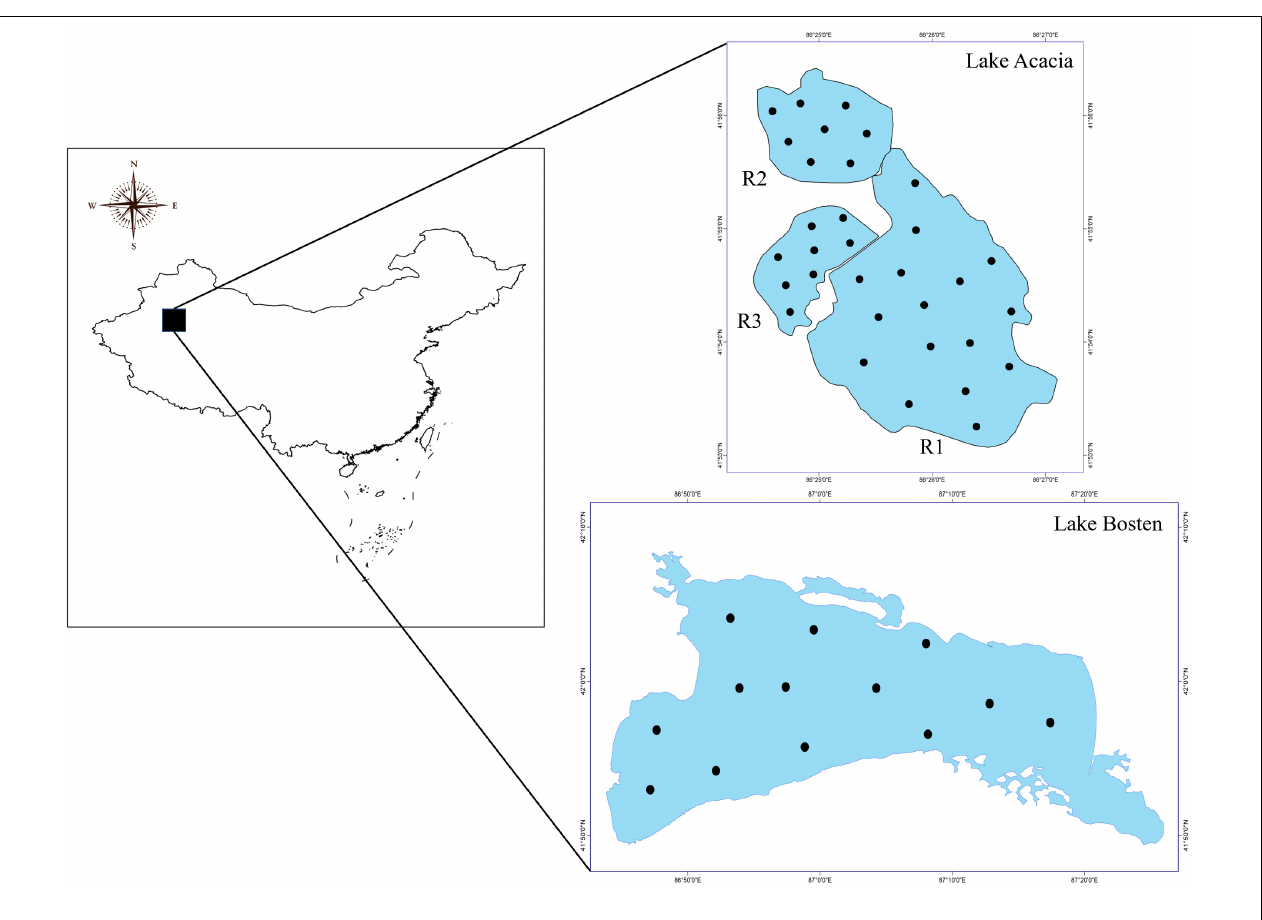
FIGURE 1 | Location of the sampling